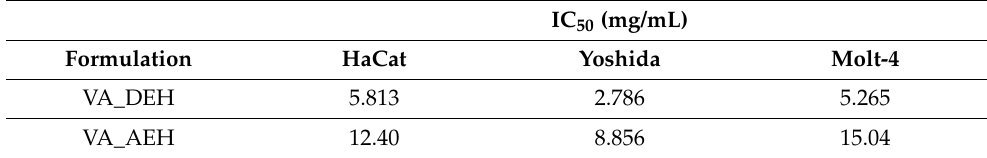
Table 6. Hydrogels IC 50 values in the tested cell lines.